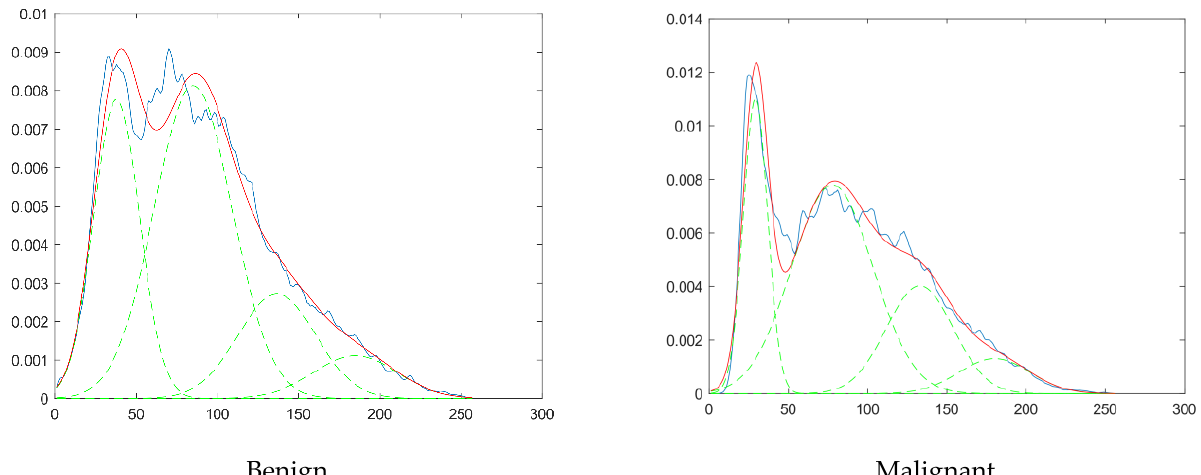
Figure 2. Histogram of features extracted from the ultrasound images. Blue: Histogram of the image, Red: Modeled histogram, Green: Gaussian Functions